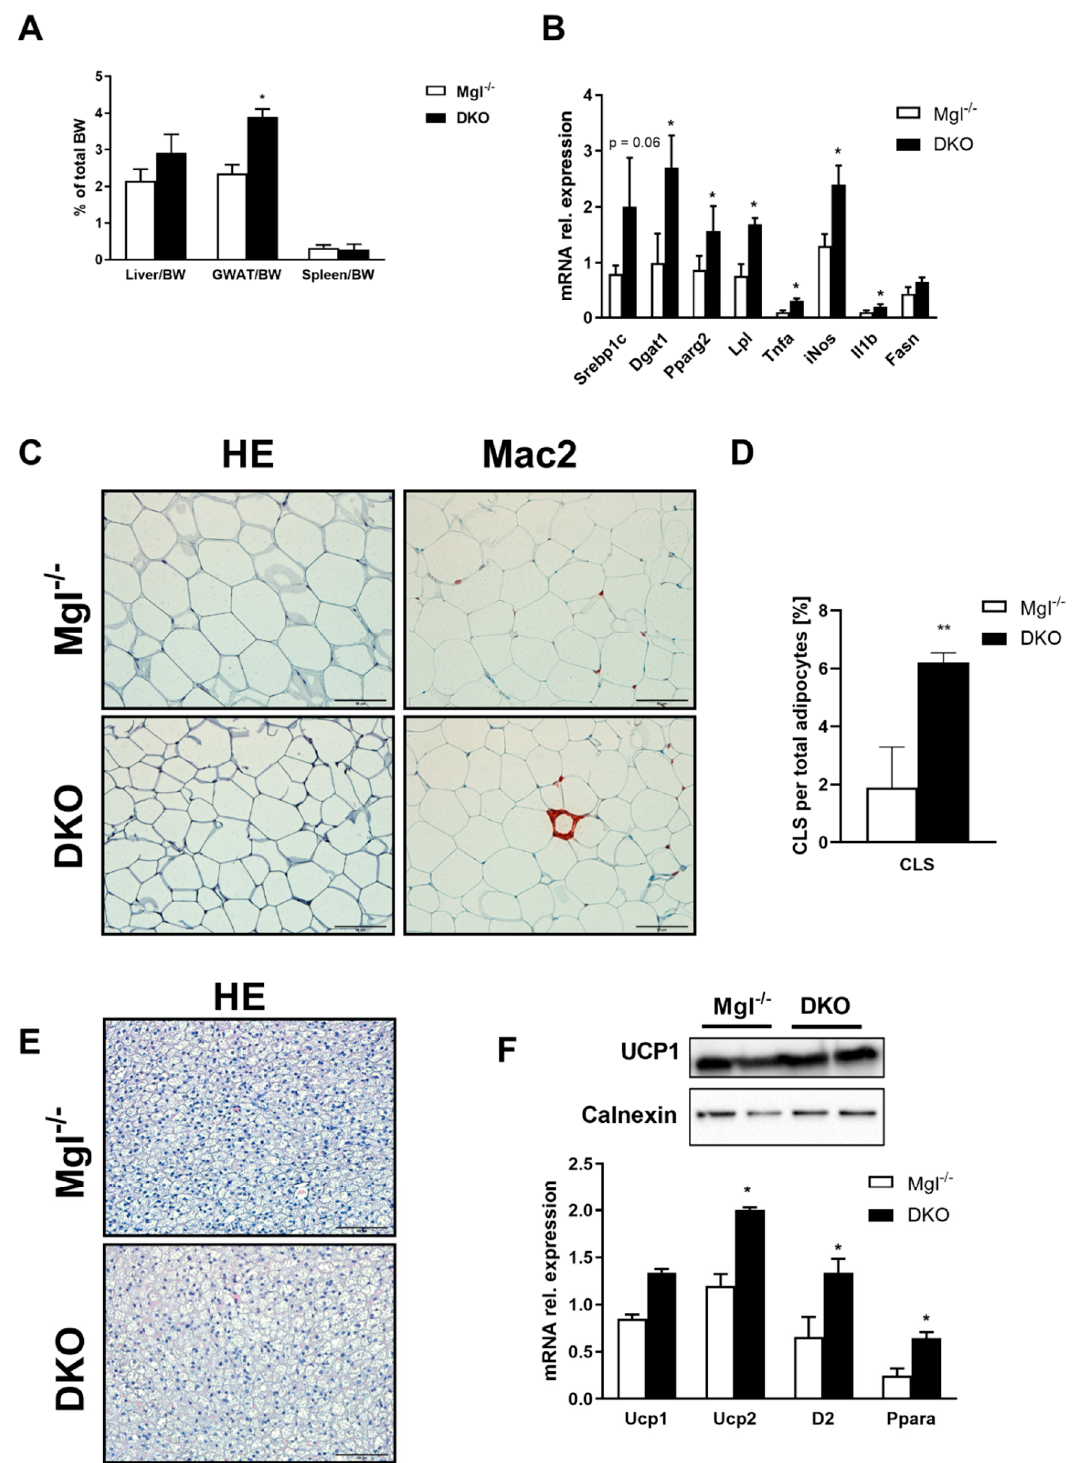
Figure 3. DKO mice show increased FA synthesis and inflammation in AT. ( A ) Liver/body weight (BW) (trend-wise) and gonadal adipose tissue (GWAT)/BW ratio increased in DKO, whereas spleen/BW did not change. ( B ) Gene expression of Srebp1c, Dgat1, Pparg2, Lpl, and Fasn (in trend) increased in DKO, whereas inflammatory markers increased for Tnfa, iNos, and Il1b . ( C ) Representative H&E images (10 × magnification) with markedly increased inflammation (Mac-2) in DKO versus Mgl − / − . ( D ) Crown-like structures (CLSs) were highly increased in DKO, as quantified by ImageJ. ( E ) Representative H&E images (10× magnification) of brown adipose tissue (BAT) in DKO . (F) Ucp1 protein expression and gene expression did not change, whereas Ucp2, D2, and Ppara increased. Results are expressed as mean ± S.D.; ** p < 0.01, * p < 0.05 for Mgl -/- versus DKO mice.